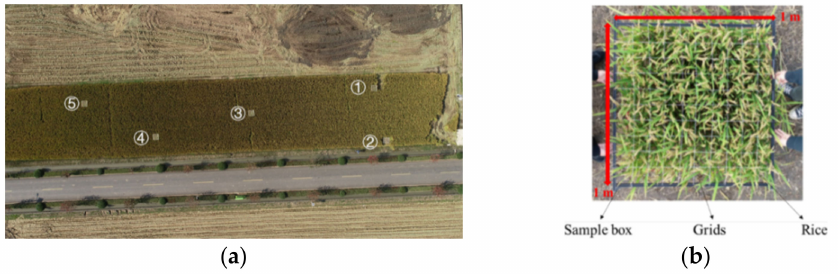
Figure 4. Rice-sample collection: ( a ) distribution of samples in the random experimental group and ( b ) sampling